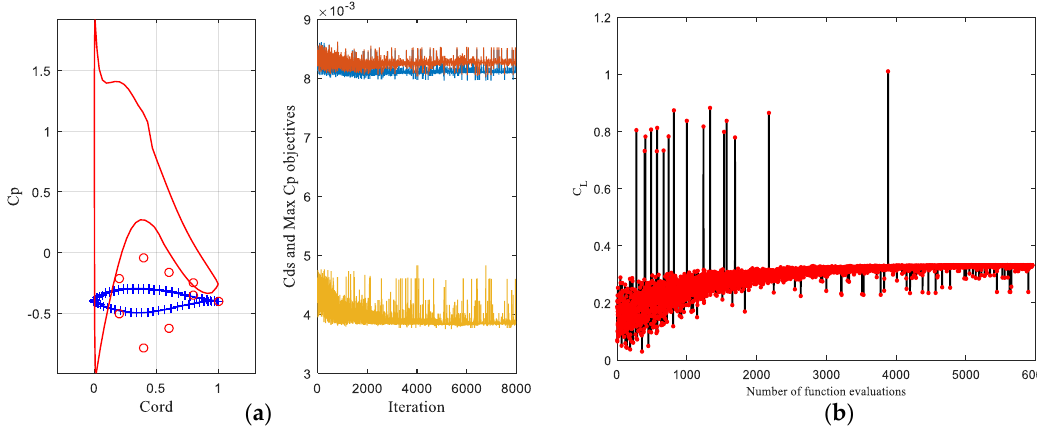
Figure 13. The convergence graph with the iterations for the NREL S809 airfoil via ( a ) the CST method and (b) the PARSEC method.